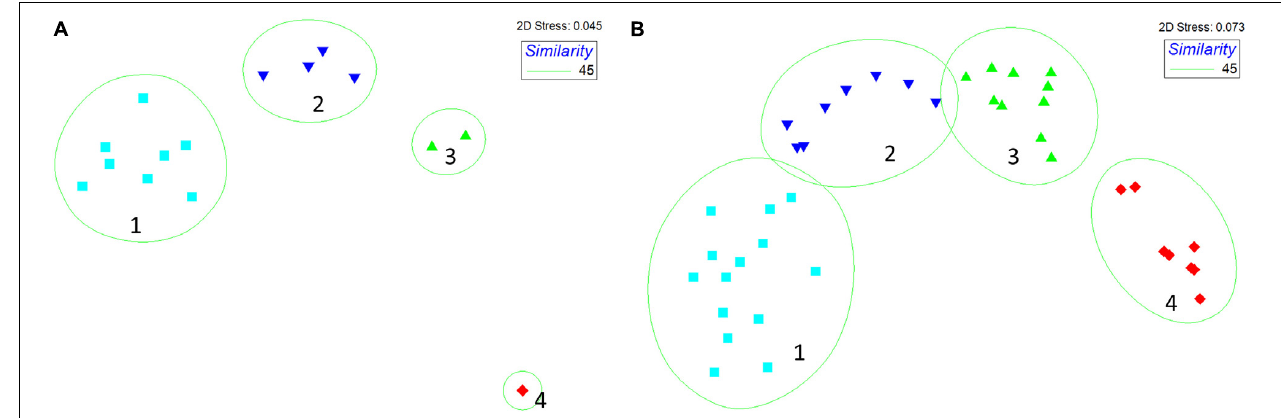
FIGURE 4 | MDS ordination for both time periods (A) 1994–2016 (15 sites) and (B) 2002–2016 (59 sites). The green lines show the results of the cluster analysis overlaid to the MDS ordination. Abundance data were square root transformed Bray-Curtis similarity was calculated. For simplicity we are presenting only the plots relative to the average similarity matrix for each time series (that was constructed by averaging species abundances at each sampling stations across all years).